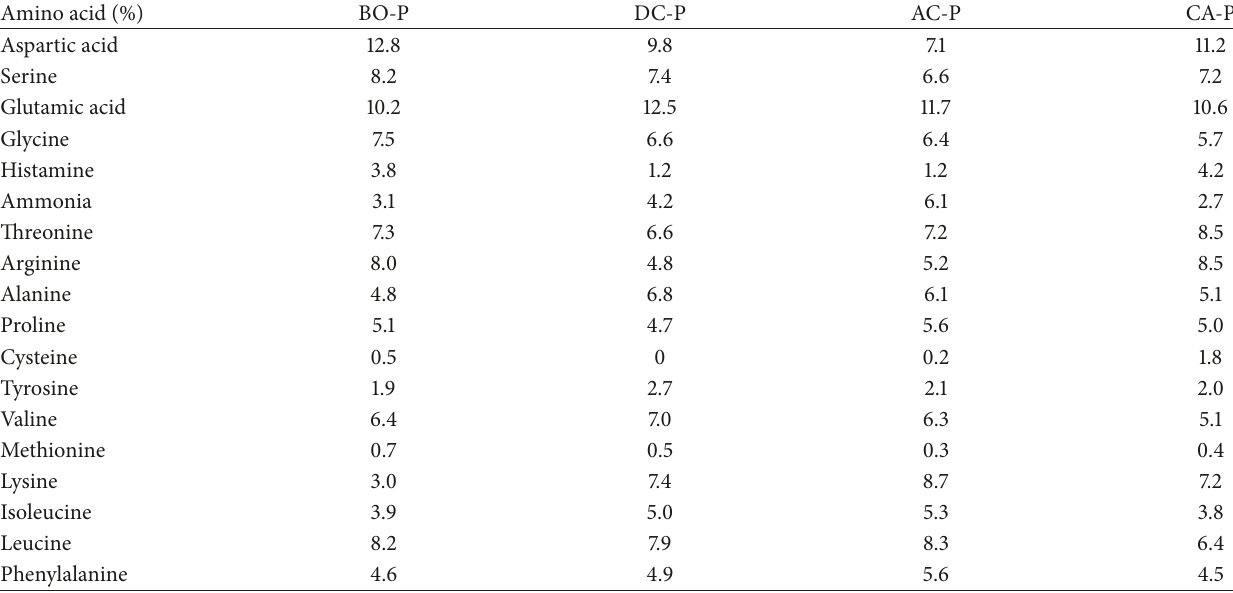
Table 2: Amino acid composition of protein contaminants of the pectin fractions studied a .